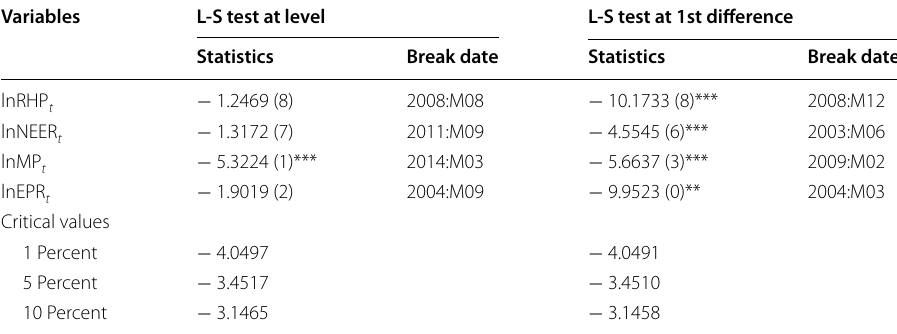
Table 4 Lee-Strazicich Unit Root Test with Structural Breaks